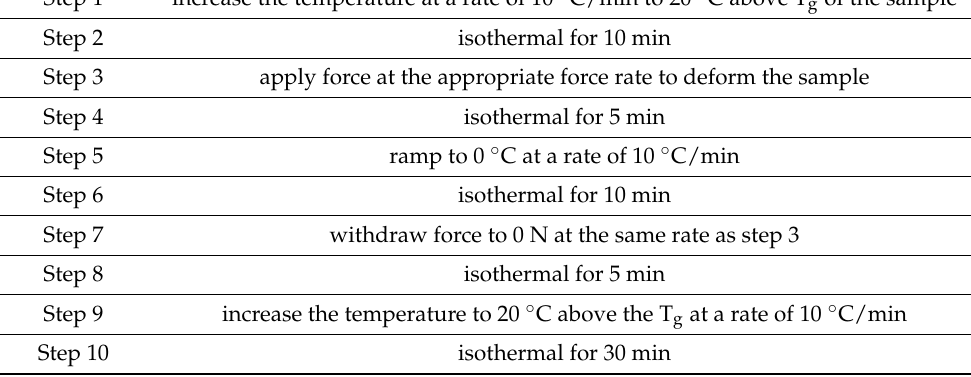
Table 2. Specific procedures of DMA for